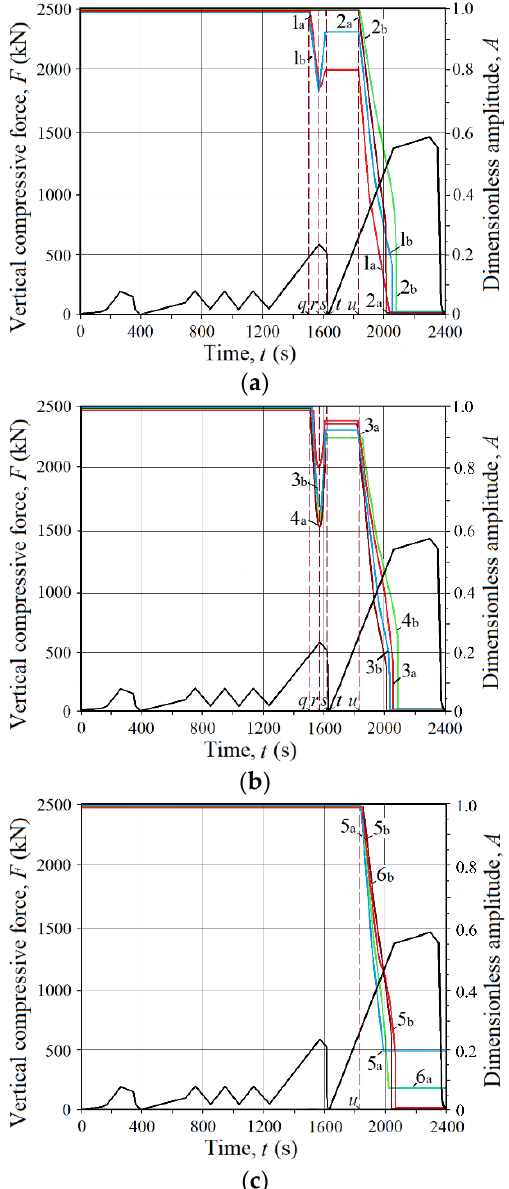
Figure 8. Plots of applied vertical compressive force F ( — ) and dimensionless amplitude of the output signal A (color lines) of the optical fibers mounted at different specimen levels vs. time t : ( a ) levels 1 and 2; ( b ) levels 3 and 4; ( c ) levels 5 and 6.